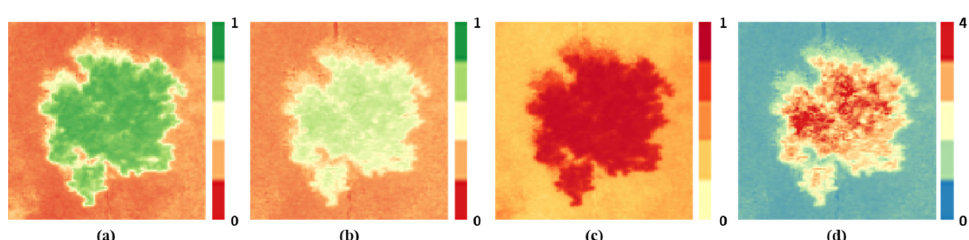
Figure 3. Examples of the VIs for individual trees: ( a ) NDVI ( b ) normalized difference RedEdge index (NDRE), ( c ) modified soil adjusted vegetation index (MSAVI), and ( d ) chlorophyll index (CI).